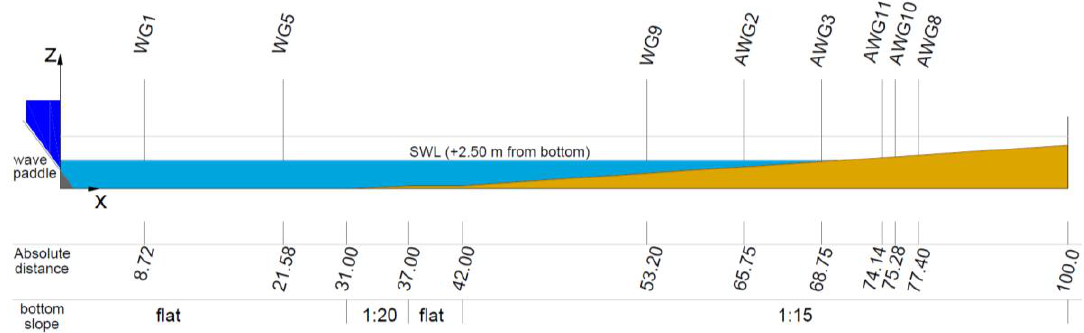
Figure 1. Universitat Politècnica de Catalunya (UPC) wave flume, longitudinal cross-section, detail of wave gauges (WG), acoustic wave gauges (AWG) location in the most active beach part and still water level (SWL) position. All measures are in m.